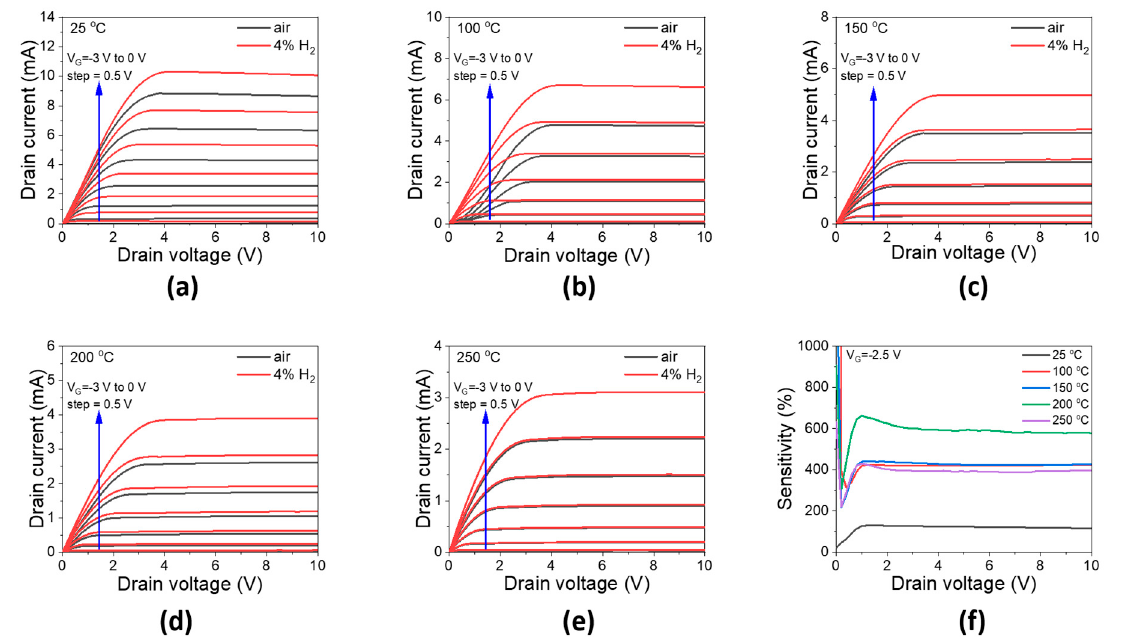
Figure 6. Output characteristics of the S3 sensor in air and 4% H 2 gas from (a) 25, (b) 100, (c) 150, (d) 200, and (e) 250 °C at di ff erent gate voltages from − 3 V to 0 V. (f) the sensitivity extracted from output characteristics at gate voltage of − 2.5 V.